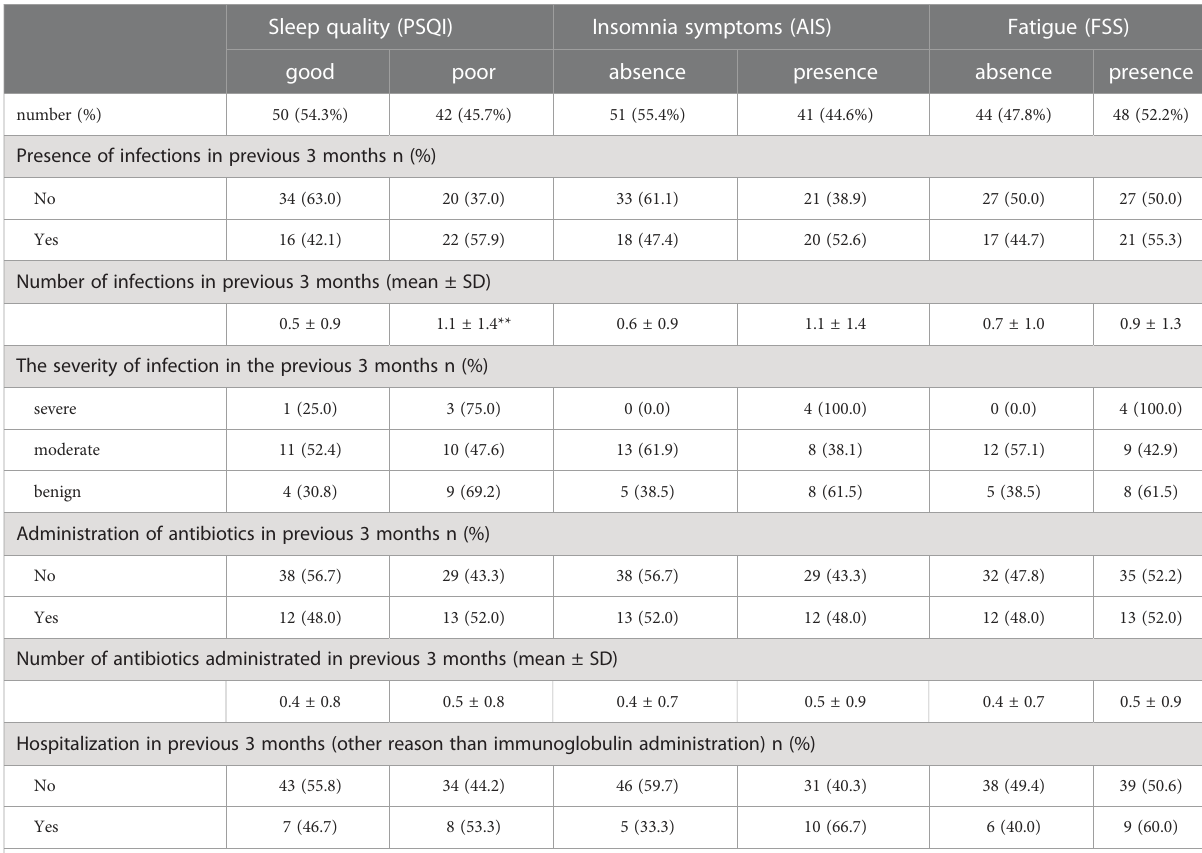
TABLE 6 Comparison of patients with good or poor sleep quality (PSQI), absence or presence of insomnia symptoms, and absence or presence of fatigue symptoms according to exacerbation of